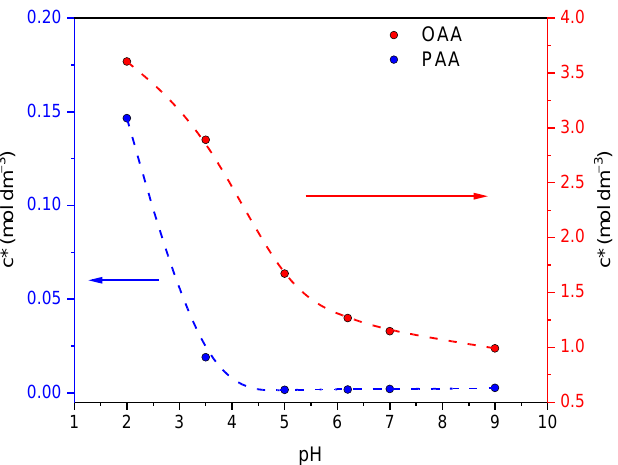
Figure 2. Critical hydrodynamic concentration ( c* ) of PAA and OAA in aqueous solutions as a function of pH, as determined by viscometry at 25.0 ± 0.1 °C.